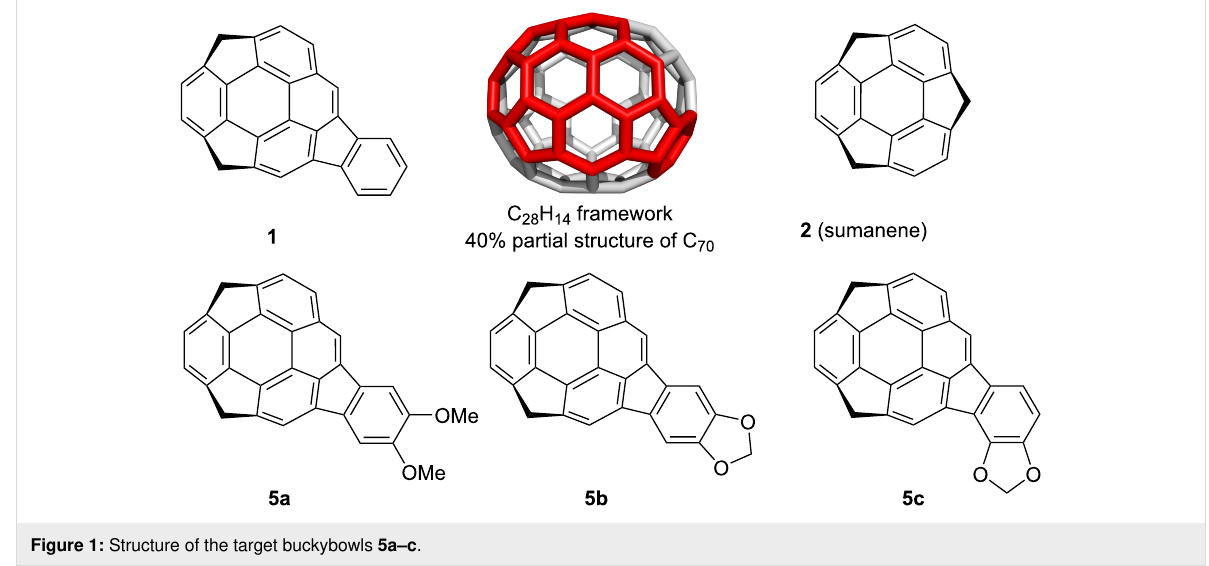
Figure 1: Structure of the target buckybowls 5a–c .